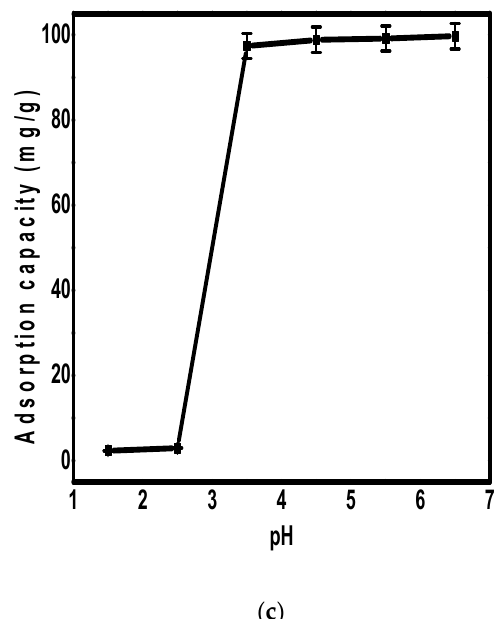
Figure 4. The effect of pH value ( a ), contact time ( b ), and initial concentration ( c ) on the adsorption of Pb 2+ ions on the surface of Fe 3 O 4 /N@C nanocomposite.